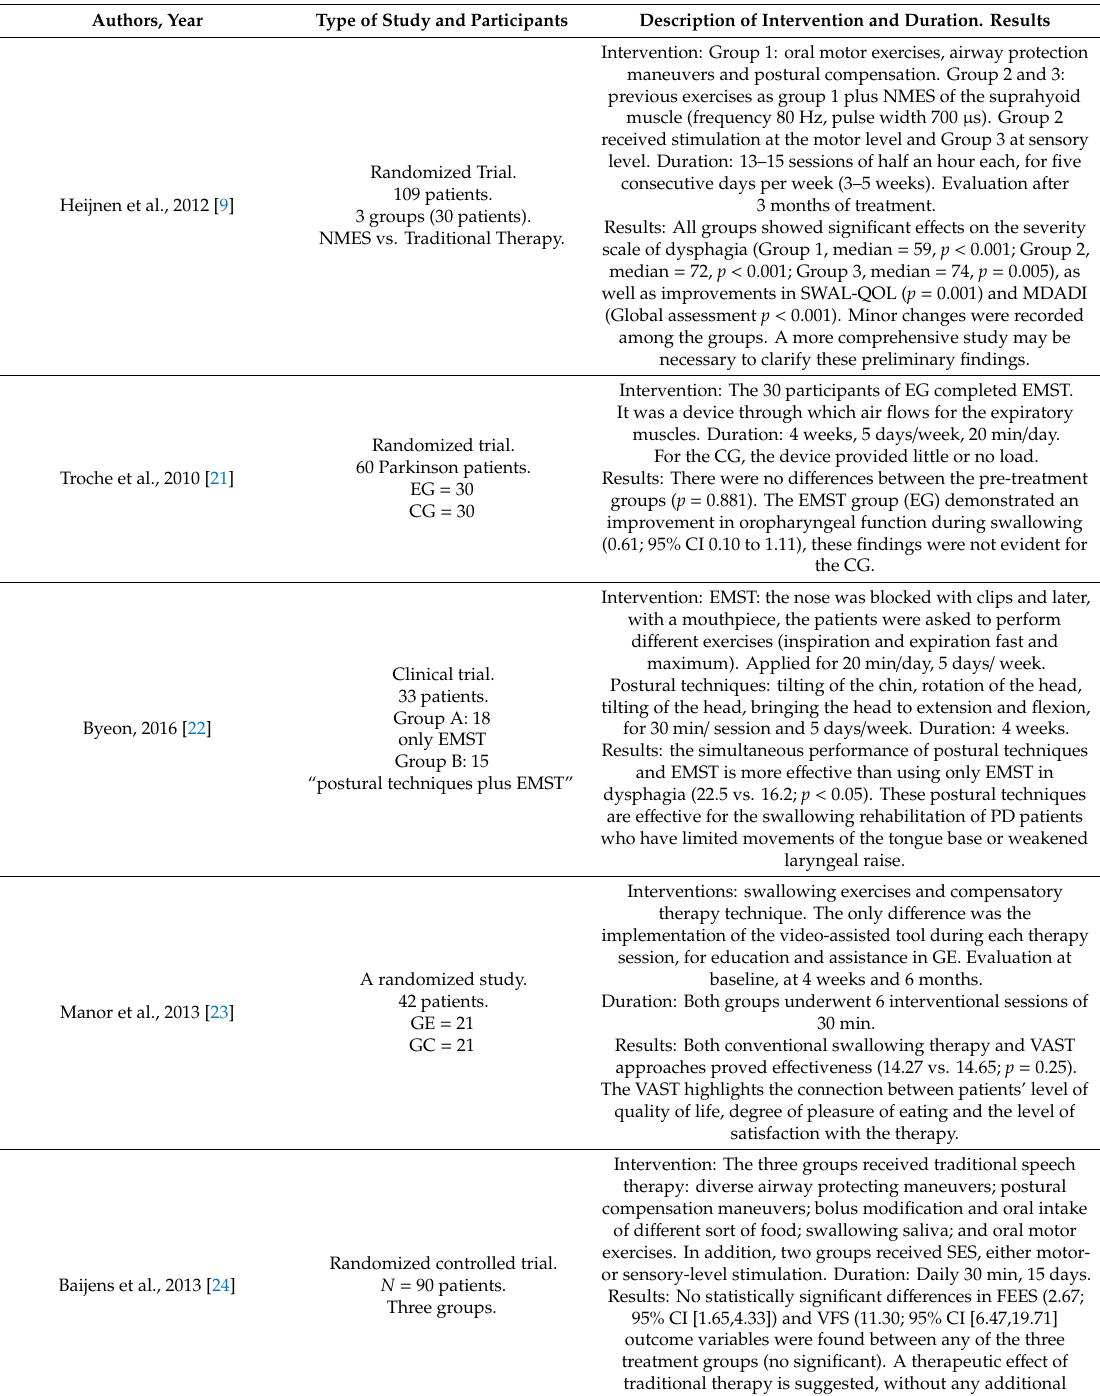
Table 2. Study characteristics and main